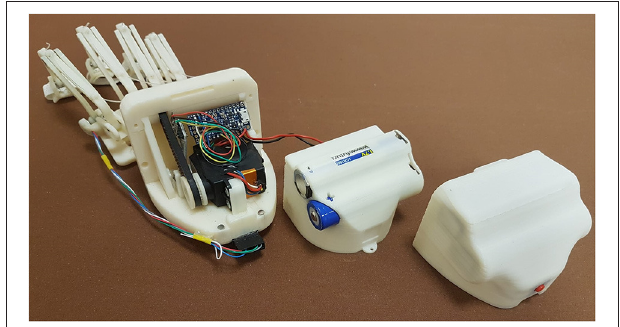
FIGURE 4 | The figure shows the two blocks of the HES modular structure: on the left, the fingers’ mechanisms module, and on the right, the motor and control one.